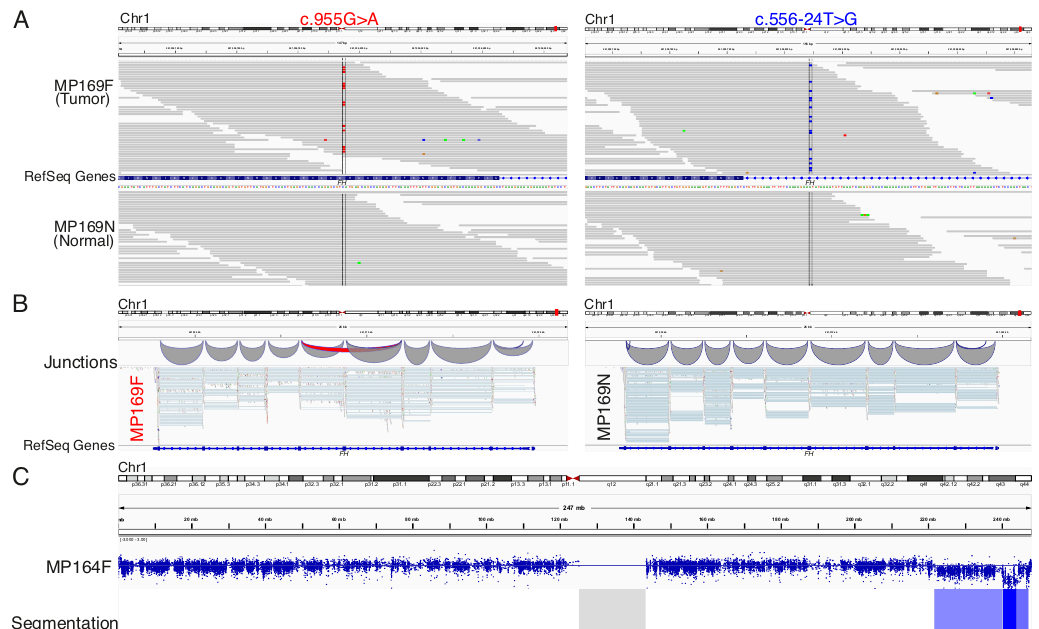
Figure 4. Biallelic loss of FH in two samples originally classified as HMGA1 overexpressing tumors. ( A ) One HMGA1 overexpressing tumor (MP169F) harbored a somatic missense variant c.955G > A, p.(Asp319Asn) in FH and a somatic substitution c.556-24T > G in intron 4 of FH . ( B ) The intronic variant resulted in RNA transcripts lacking exon 5. ( C ) Copy number analysis revealed a homozygous deletion encompassing FH in the other sample (MP164F).